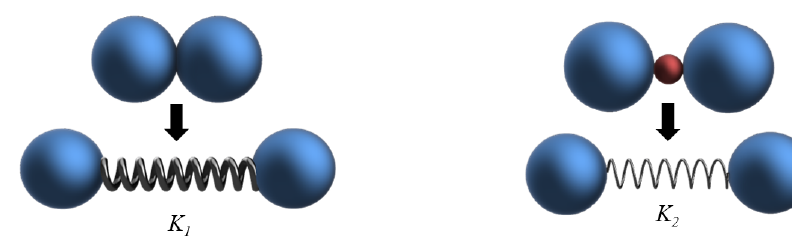
Figure 8. Adopted method for simulating fouled ballast; ( a ) changes to the interparticle friction coefficient due to the presence of fines; ( b ) changes to interparticle contact stiffness due to the presence of fines.